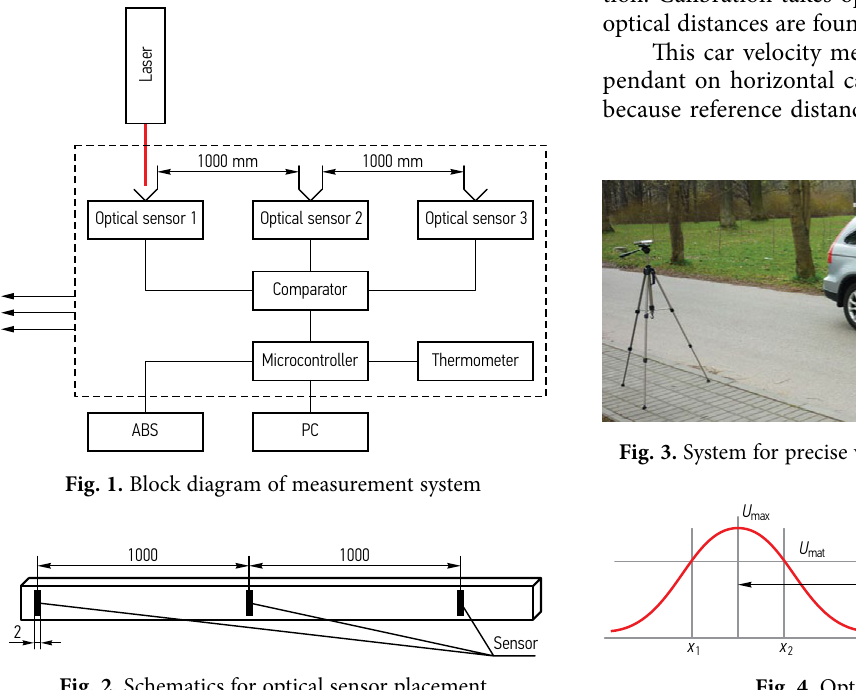
Fig. 4. Optical sensor